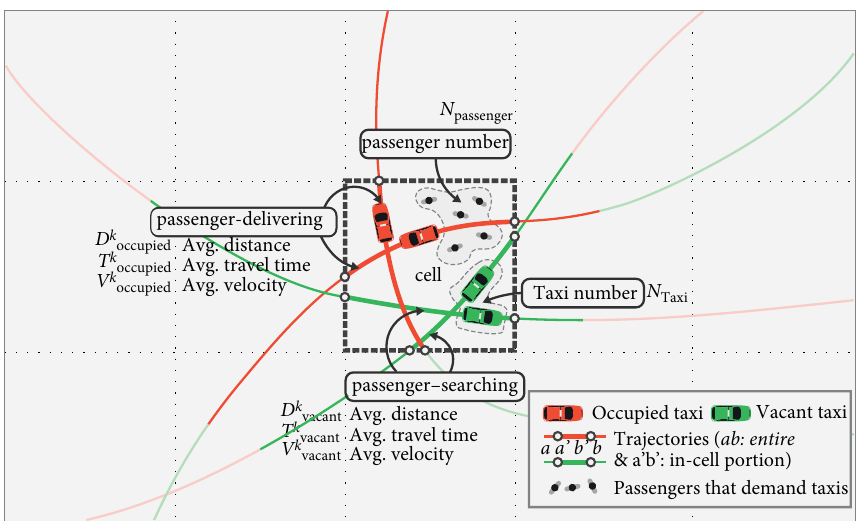
Figure 4: Defining factors that affect taxi operations based on search and delivery